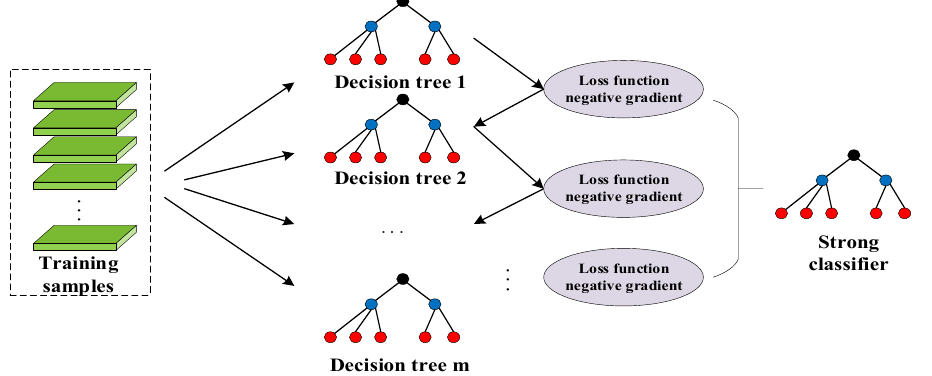
Figure 4. The framework of the GBDT algorithm.